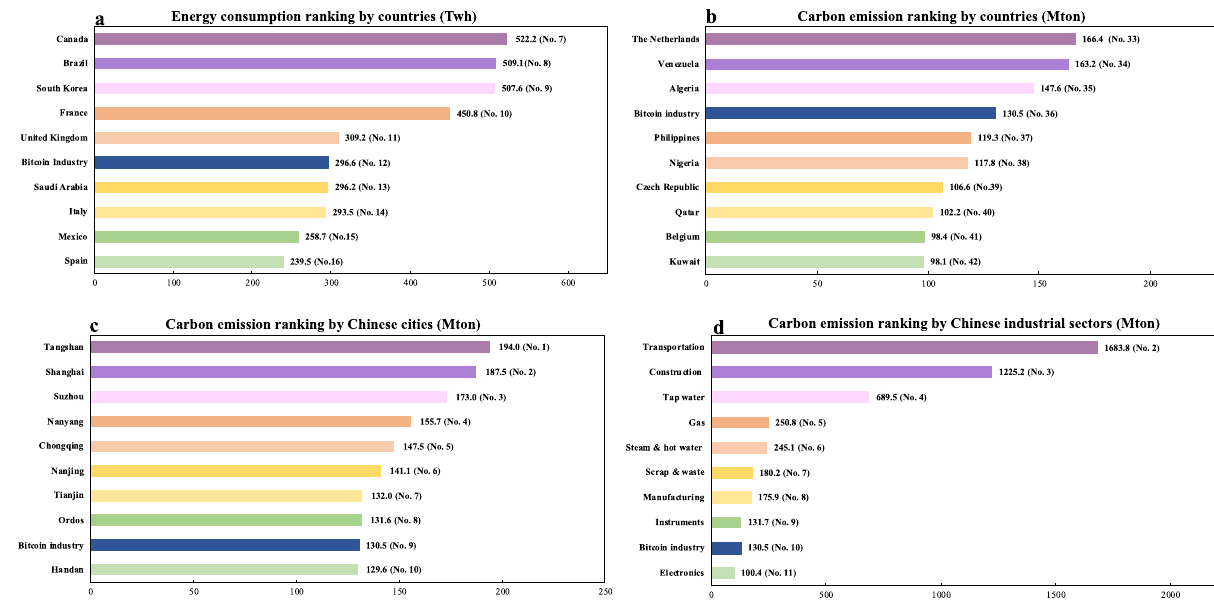
Fig. 3 Bitcoin industry energy consumption and carbon emission comparisons. In Fig. 3, the peak energy consumption and carbon emission of Bitcoin industry are compared to national level emissions of other countries as well as to the emissions of domestic cities and industrial sectors in China. Annual energy consumption and ranking by countries a are obtained from cia.gov (www.cia.gov), carbon emission and ranking by countries b are collected from global carbonatlas (www.globalcarbonatlas.org). The carbon emission by Chinese cities (c ) and industrial sectors ( d ) are obtained from China Emission Accounts and Datasets (www.ceads.net). Due to the unreleased or missing data in some database, the above energy consumption and carbon emission data are obtained for 2016